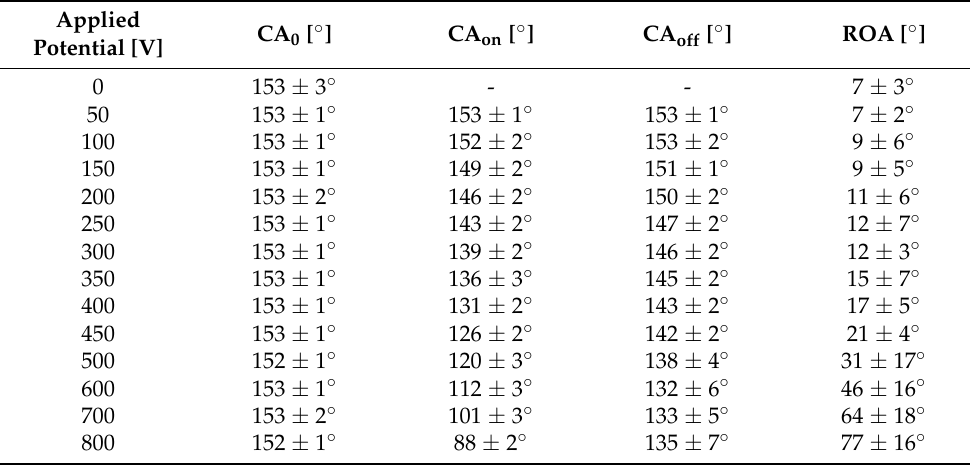
Table A1. Measured CAs and ROAs from wetting behavior